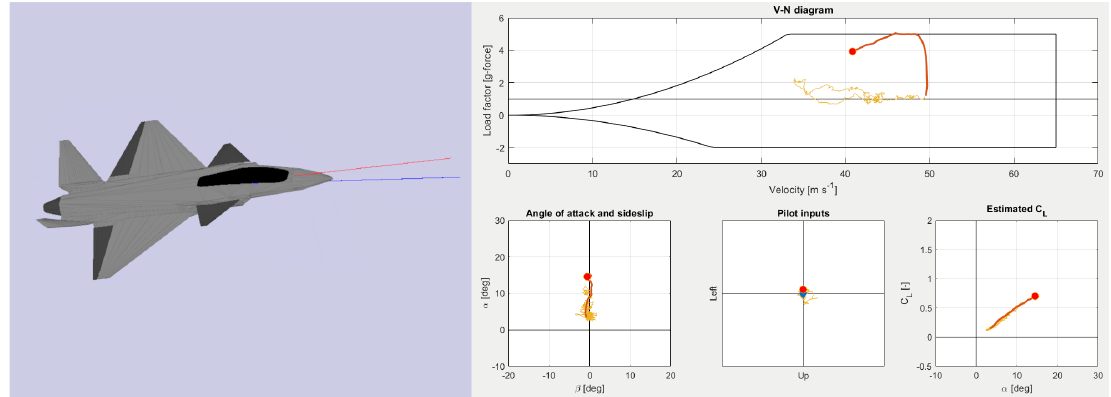
Figure 13. Post-flight, animated data visualisation in ALAN software showing a manoeuvre of the GFF